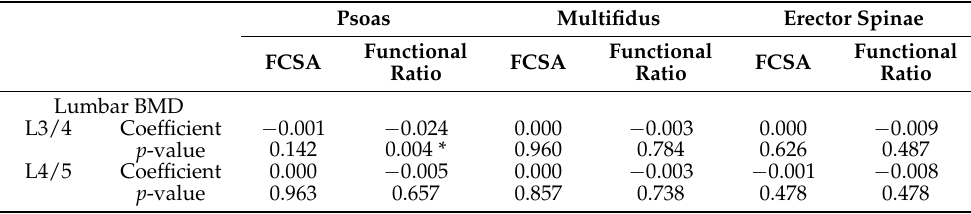
Table 6. Generalized linear mixed models to evaluate the effect of lumbosacral radiculopathy on the relationship between lumbar BMD and lumbar spinal muscle morphometry on the involved and uninvolved sides. Psoas Multifidus Erector Spinae Functional Functional Functional FCSA FCSA FCSA Ratio Ratio